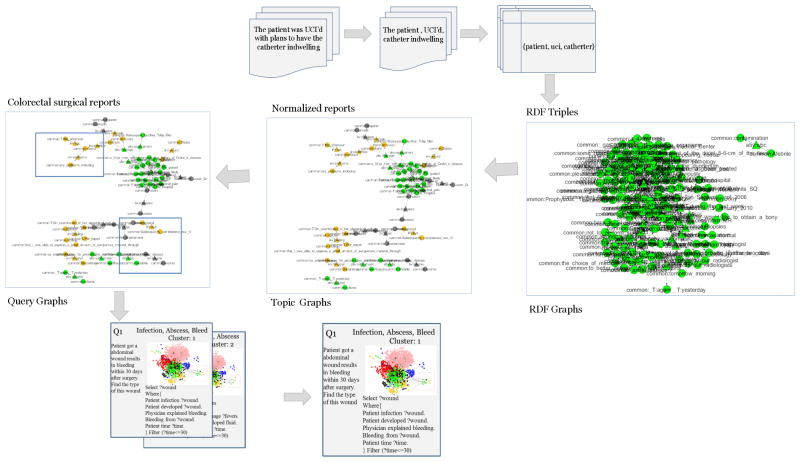
The BmQGen dataflow.